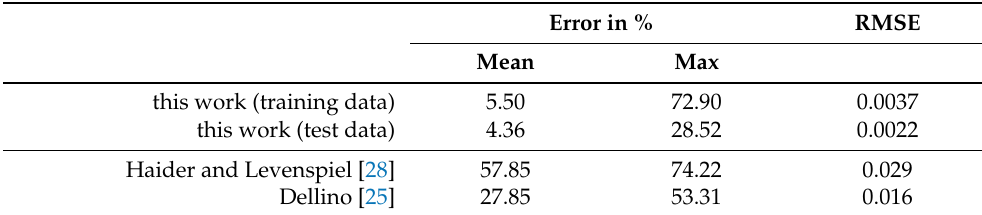
Table 8. Performance of the model obtained by polynomial regression on the training and test data, along with errors of the model of Haider and Levenspiel [28] and the one by Dellino [25] on the training data.